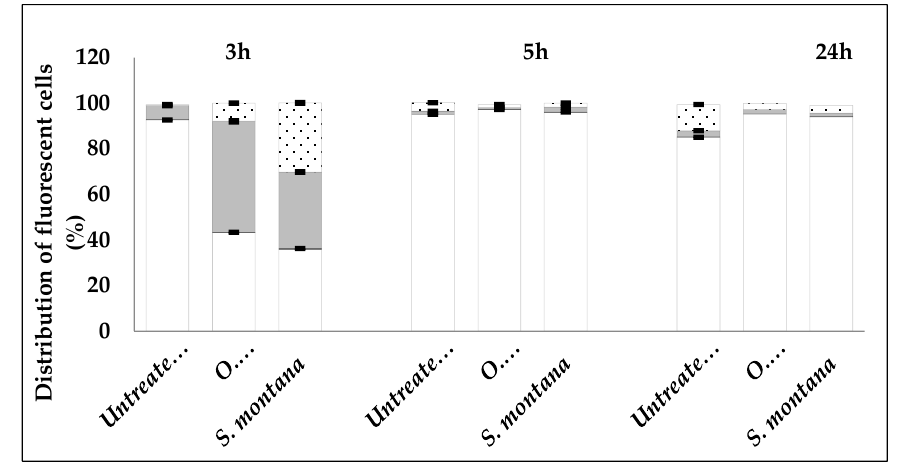
Figure 1. Membrane integrity of S. aureus ATCC 25923 after 3, 5, and 24 h exposure to Satureja montana and Origanum majorana decoctions at 1.56 mg/mL. White bars with dots represent cell fragments or unstained cells; white bars represent cells with intact cell membranes; Gray bars represent cells with slight cell membrane permeabilization; Black bars represent cells with (complete) cell membrane permeabilization. The means ± standard deviations for three independent assays are presented.